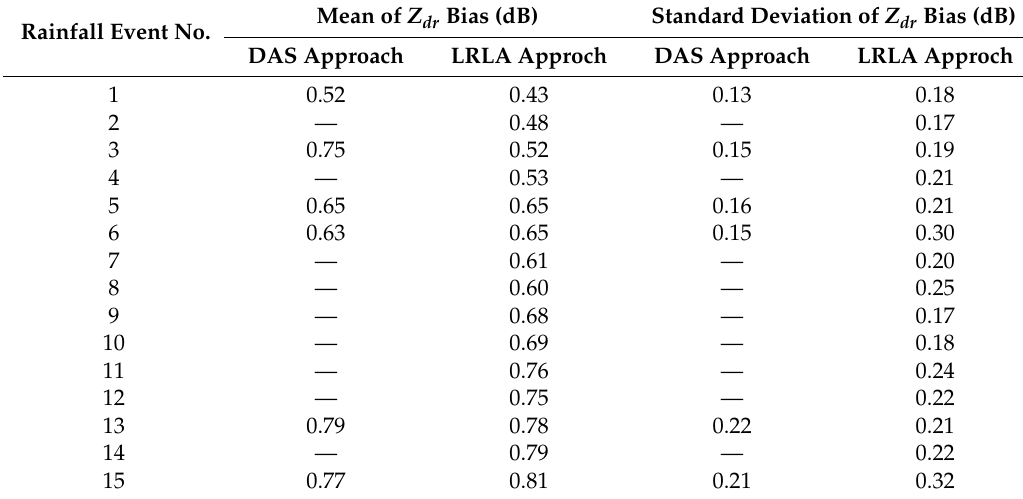
Table 4. Mean and standard deviation of Z dr bias estimated by the DAS 1 and LRLA 2 approaches for all rainfall